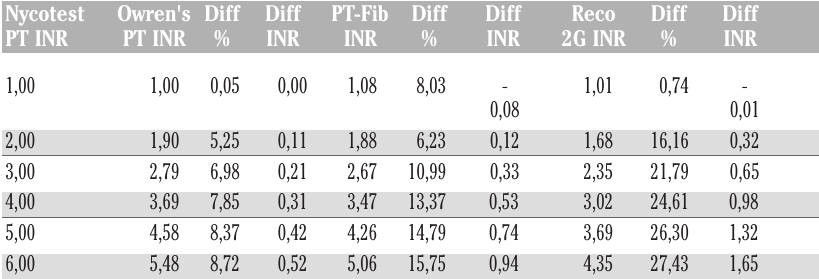
Table 1. Differences in INR results between four PT methods at variable INR levels as INR units and percentages. The correlation equations between methods were used for the